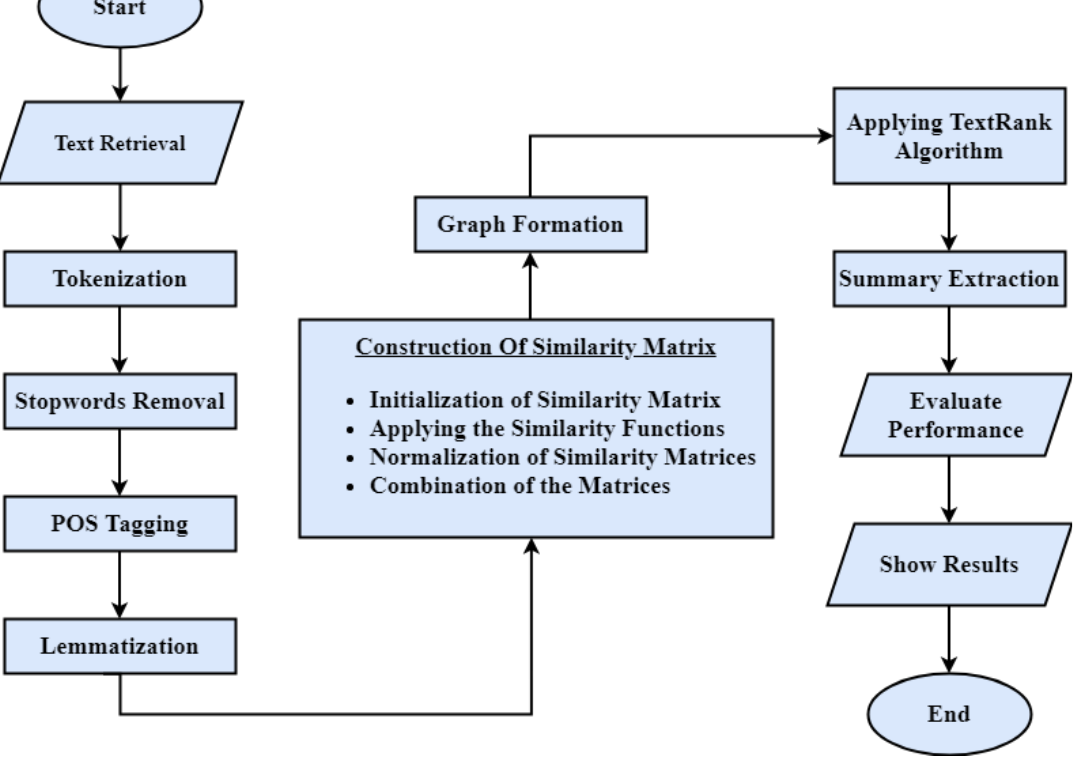
Figure 1. Proposed model overview.